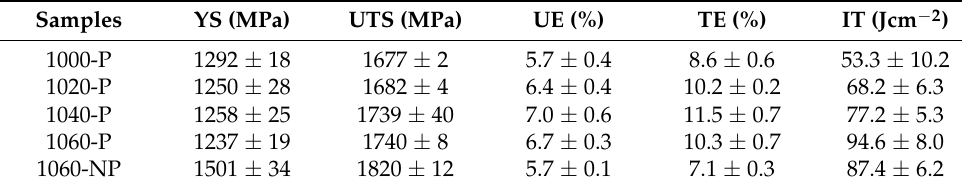
Table 2. The results of the tensile and impact tests.